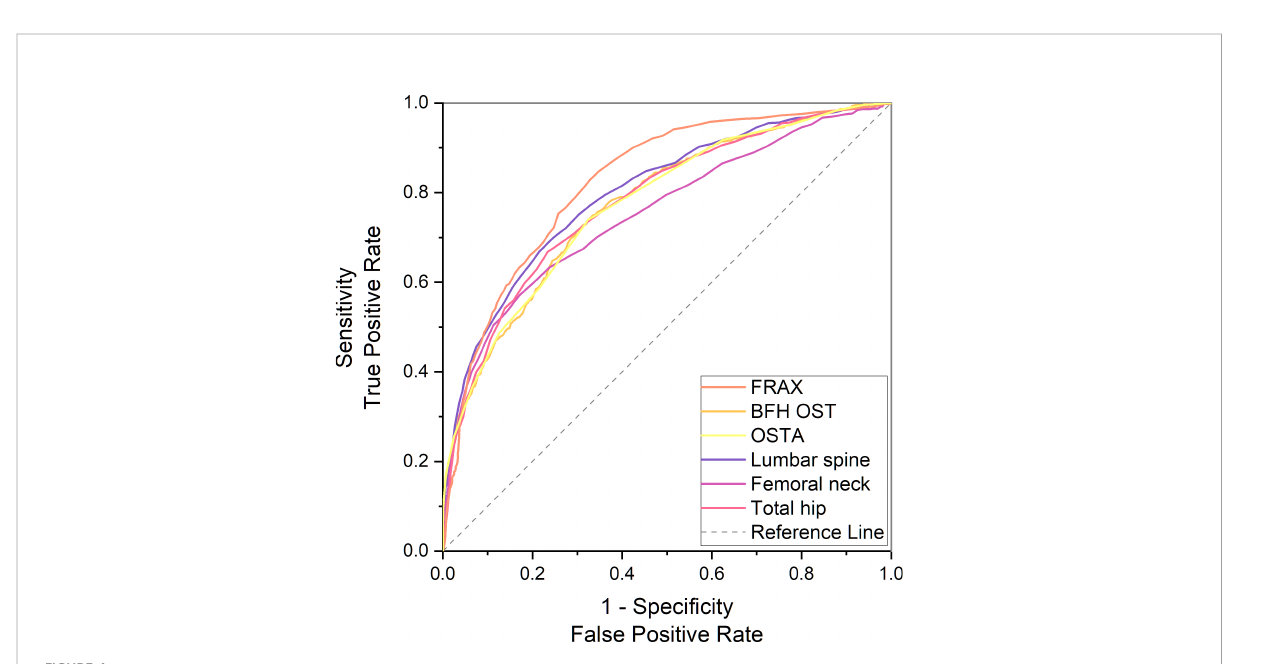
FIGURE 4 Comparison of different AUCs, including FRAX without BMD, BFH-OST, OSTA, and BMD T-score for identifying PNOVFs.